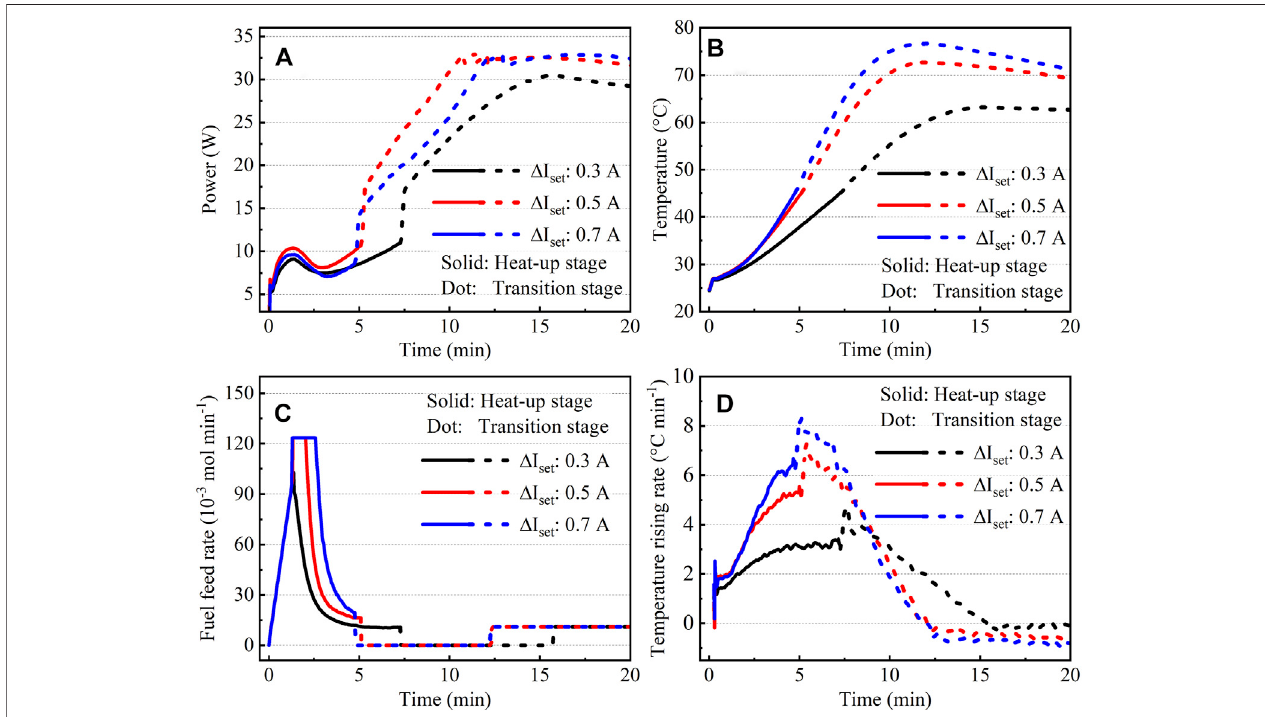
FIGURE 6 | Pro fi les of the (A) power, (B) temperature, (C) fuel feed rate, and (D) temperature rising rate of the DMFC during startups at various Δ I set . C ini : 0.3 mol L − 1 ; T ini : 23 ° C; V set : 0.45 V cell − 1 .